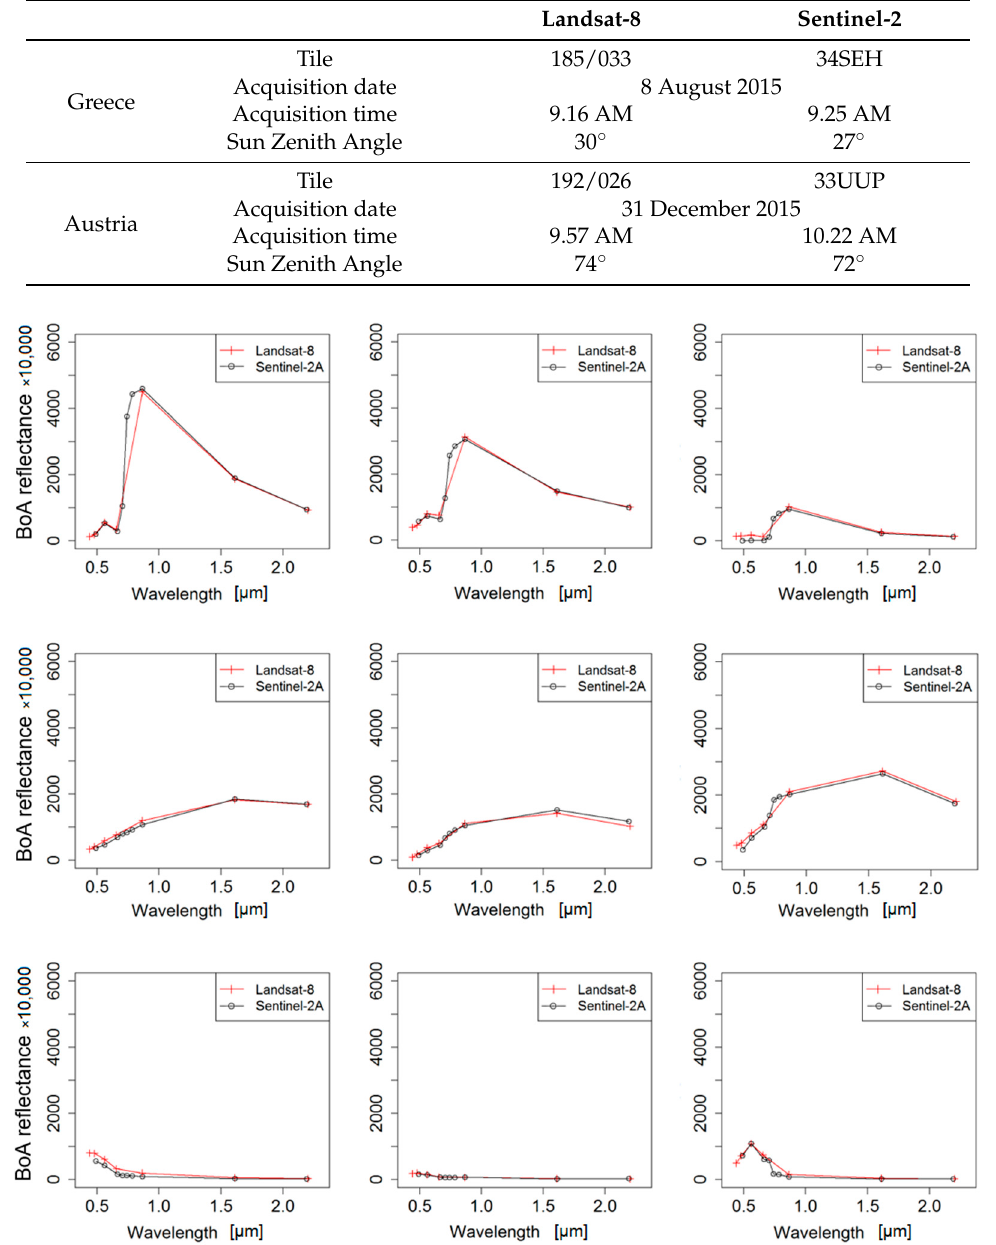
Table 2. Contemporaneous Landsat-8 and Sentinel-2 acquisitions used for comparison.